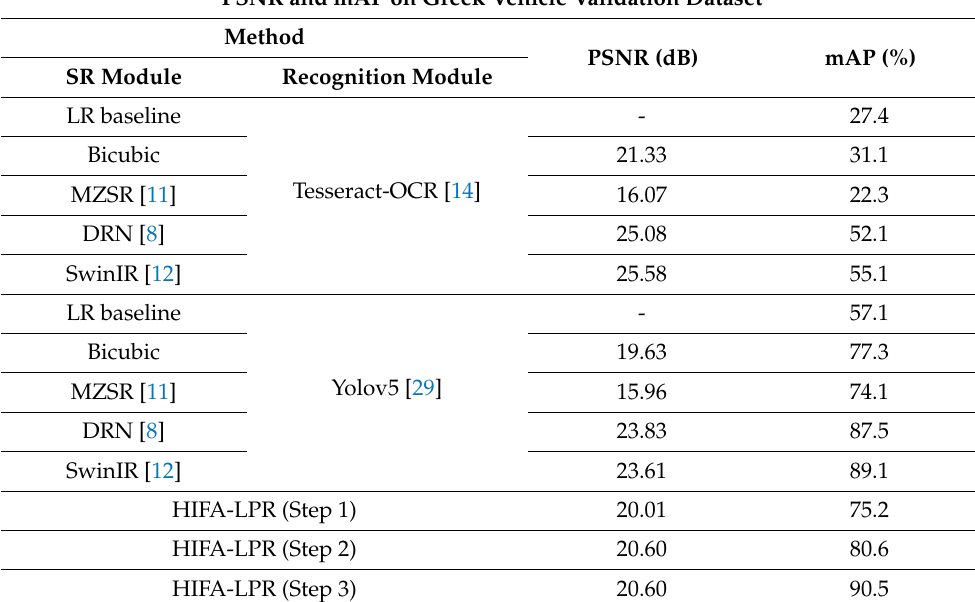
Table 4. Comparison between the HIFA-LPR model and other existing approaches for scale factor ( × 4) on the Greek vehicle